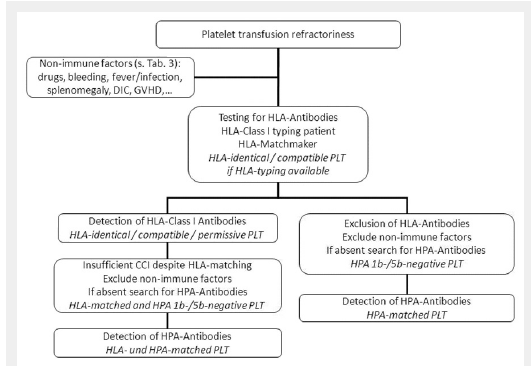
Proposed algorithm for the management of patients with platelet transfusion refractoriness. DIC = disseminated intravascular coagulation; GVHD = graft- versus-host disease; HLA = human leucocyte antigen; HPA = human platelet antigen; PLT = platelet components Definitions: